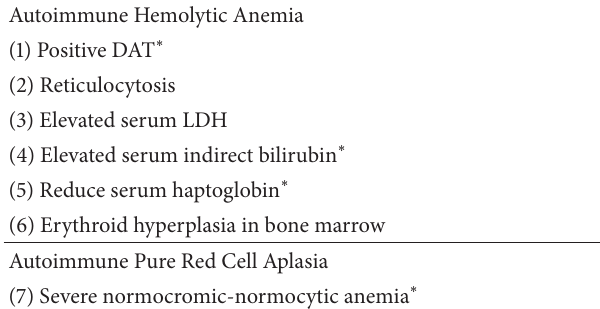
Table1:Reportedincidenceofautoimmunecytopeniacomplicating CLL.